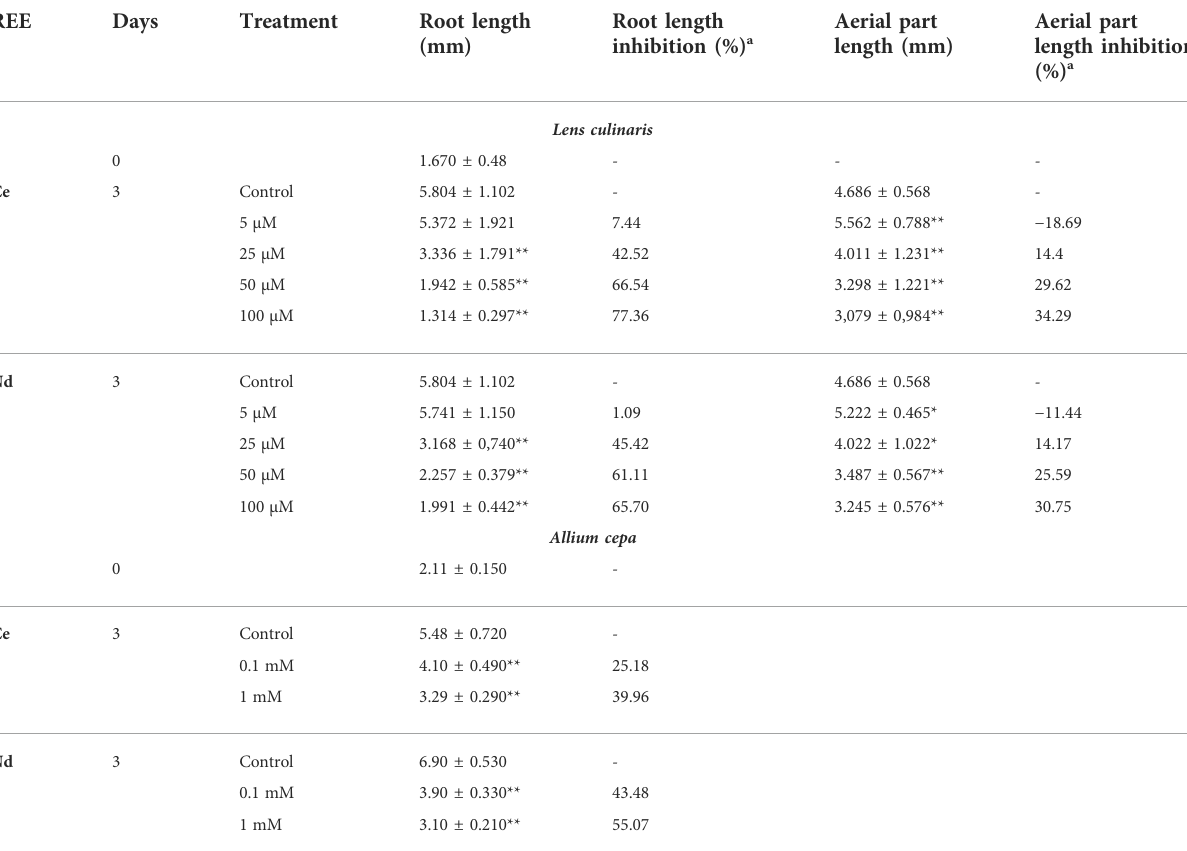
TABLE 2 Effect of different concentrations of Cerium (Ce) and Neodymium (Nd) on root and aerial part length in lentil and on root length in onion. Values are expressed as average ±standard deviation (n = 43).* Statistical signi fi cance at p < 0.01 (*), p < 0.001 (**). REE